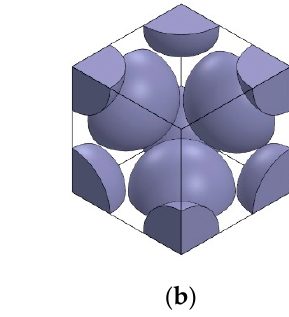
Table 9. Values of PF for several situations.